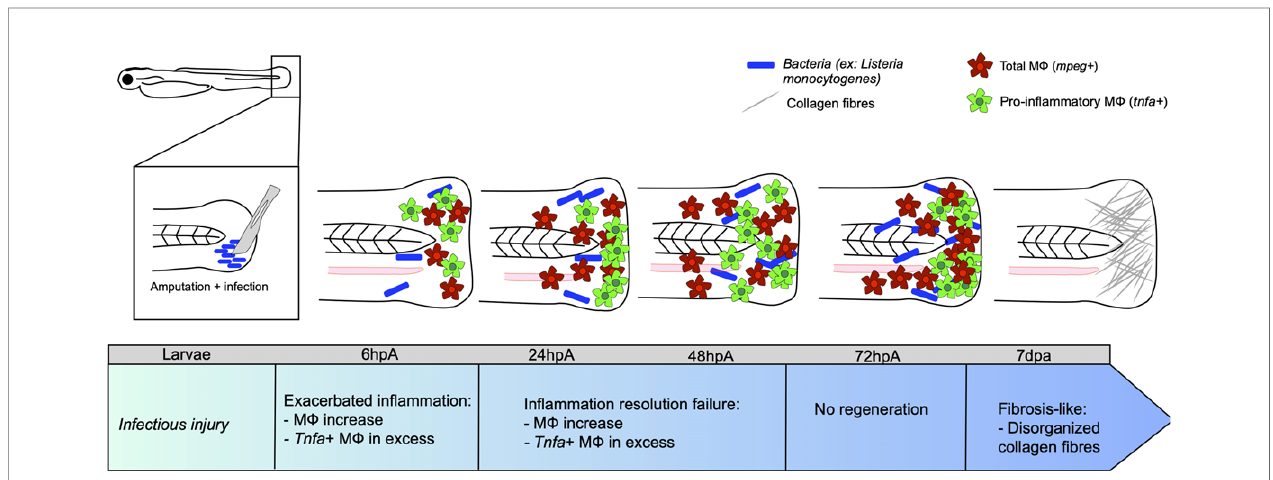
FIGURE 2 | Caudal fi n regeneration under infectious conditions. Amputation of the caudal fi n in an infectious condition, with a scalpel pre-soaked in a solution containing pathogenic microorganisms (for instance Listeria monocytogenes ) impairs tissue regeneration. Exacerbated in fl ammation is caused by an excessive number of tnfa- positive M Ф at the wound. Resolution of in fl ammation is impeded at 24 hpa, with many tnfa- positive M Ф that remain present. This results in incomplete tissue restoration and fi brosis at 7 dpa onward, characterized by the presence of disorganized collagen fi